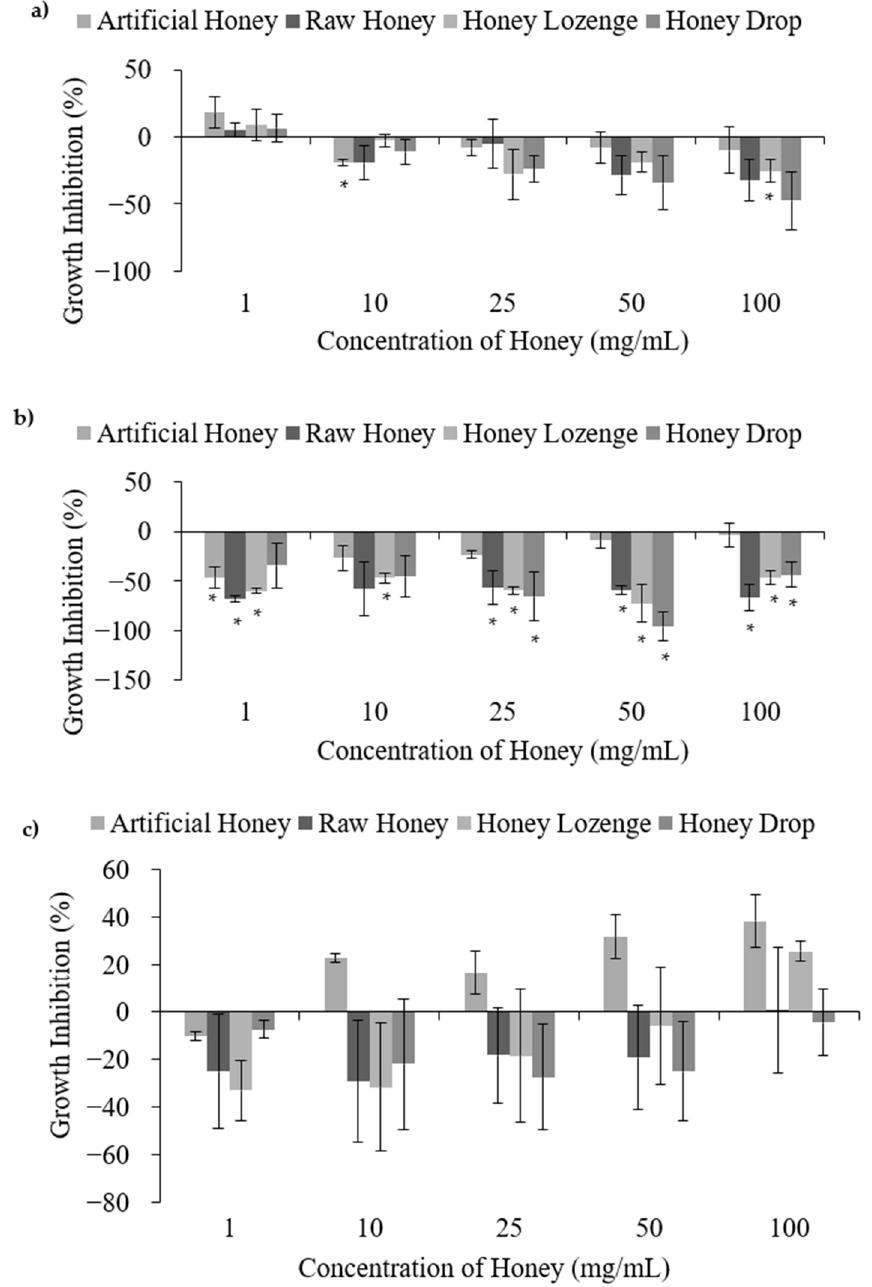
Figure 3. Pro-bacterial activities of honey with ( a ) B. subtilis , ( b ) S. epidermidis , and ( c ) L. acidophilus , upon treatment with different concentrations of raw and processed honey samples. Artificial honey is included as a control for the sugar content of honey. * Indicates significant difference from the negative control.